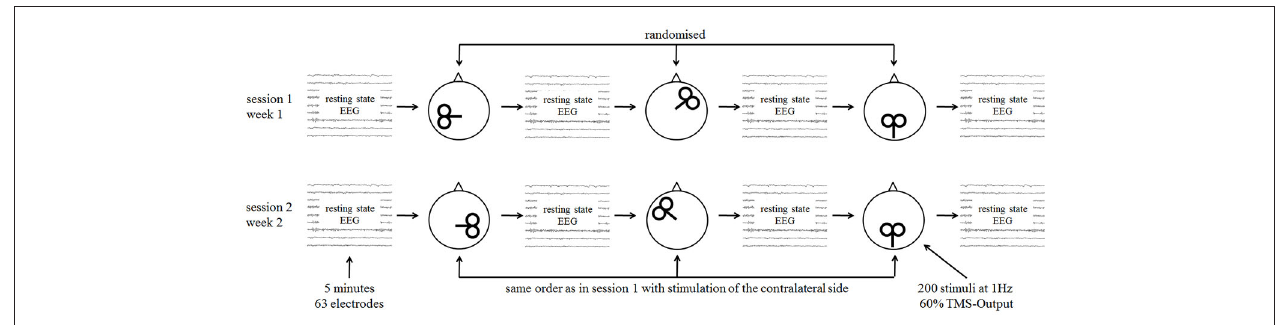
FIGURE 1 | Study procedures with single sessions of repetitive transcranial magnetic stimulation (rTMS) and measurement with resting state electroencephalography (EEG).